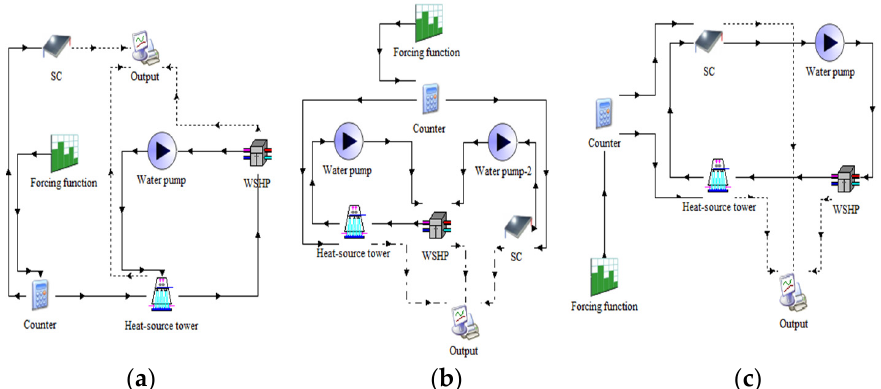
Figure 5. The TRNSYS model diagram of three combined heating systems: ( a ) SC//HP ( b ) SC+HP ( c ) HST+SC.